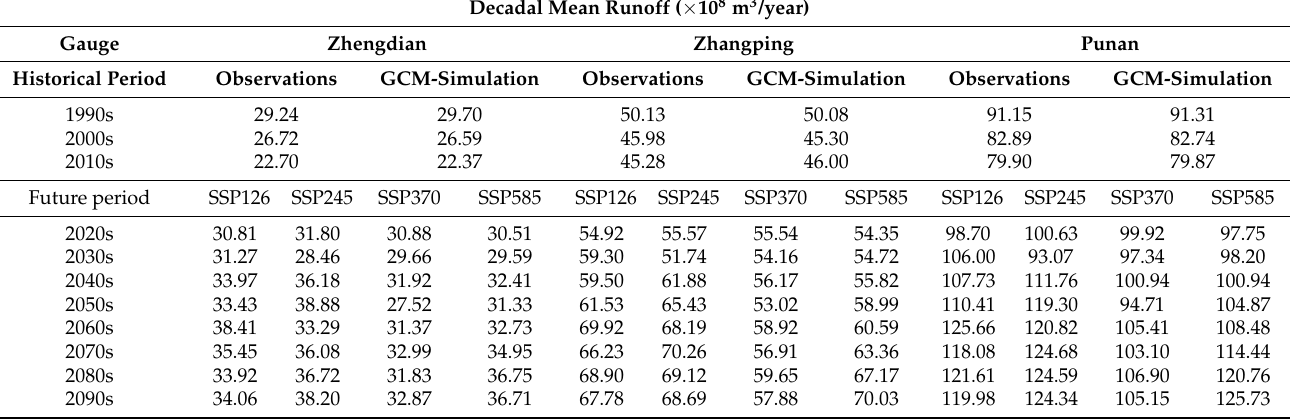
Table 3. Annual mean runoff at the Zhengdian, Zhangping and Punan stations under the four